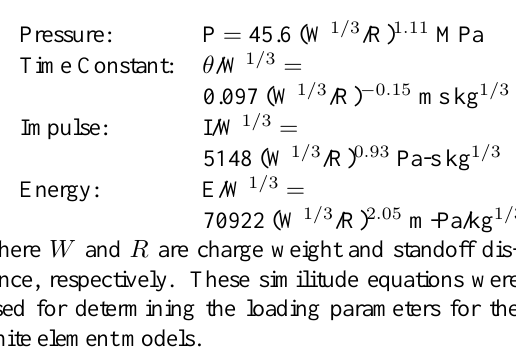
Fig. 2. Schematic drawing showing the arrangement employed for securing the test plate to the shock